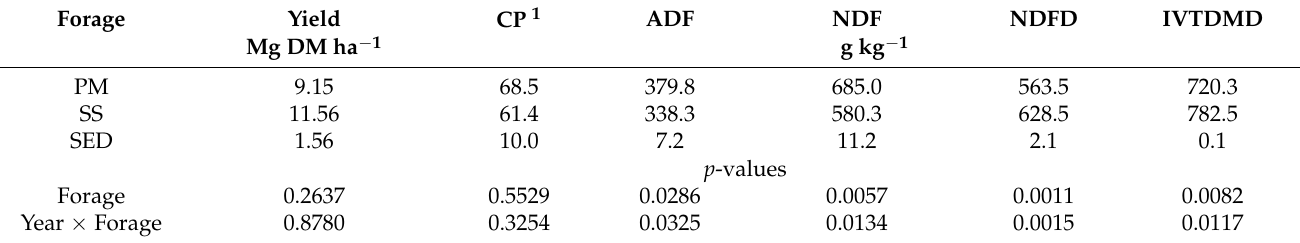
Table 1. Dry matter (DM) yield and nutritive value of freeze-killed pearl millet (PM) and sorghum–sudangrass (SS) from a single cutting at Tucumcari, NM, USA, in 2013 and 2014 (130 and 140 days after planting in 2013 and 2014, respectively). Data are the least squares means of two replicates and two years.